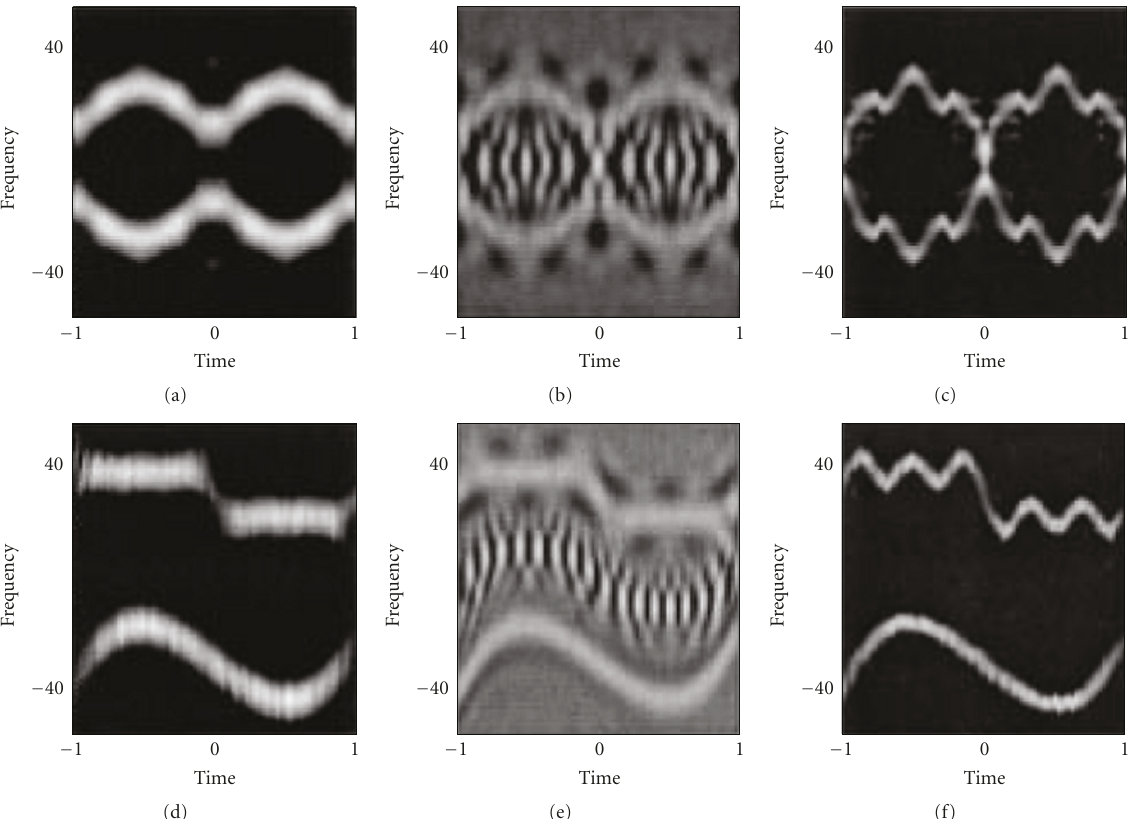
Figure 20: TFD of a multicomponent signal with highly nonlinear IF. Spectrogram (a), (d), WD (b) , (e), complex-lag distribution (c) , (f). (a) , (b), (c): noisy signal with SNR = 30dB. (d), (e) , (f): noisy signal with SNR = 20 dB (all adopted from Stankovic